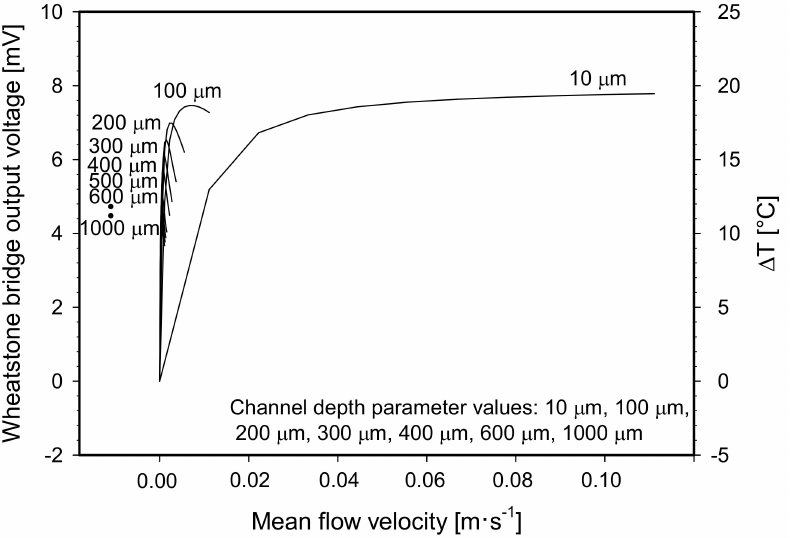
Figure A1. Constant temperature S-H-S flowmeter configuration: simulated Wheatstone bridge output voltage and differential temperature between both sensor elements vs. mean flow velocity for preselected channel depth parameter